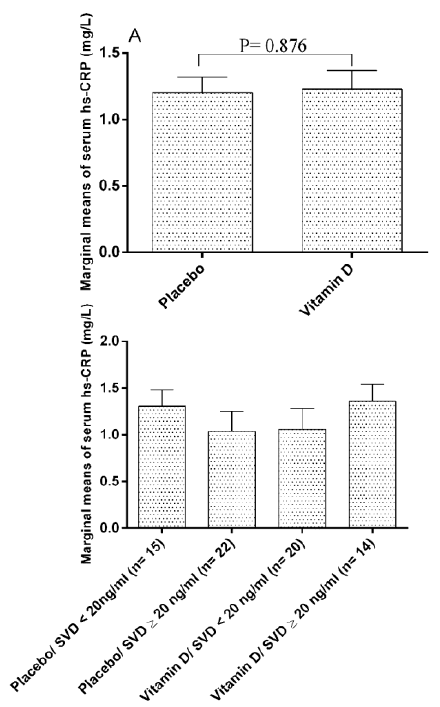
Figure 3. Estimated marginal means of the serum levels of hs-CR p in the study groups. Data are presented as Estimated Marginal Means ± SE. data analysis was done by ANCOVA after adjustment of baseline values. hs-CRP: high sensitive C-reactive protein; SVD: Serum Vitamin D. Estimated marginal mean: Post-intervention values after adjusting for baseline values between the study groups.